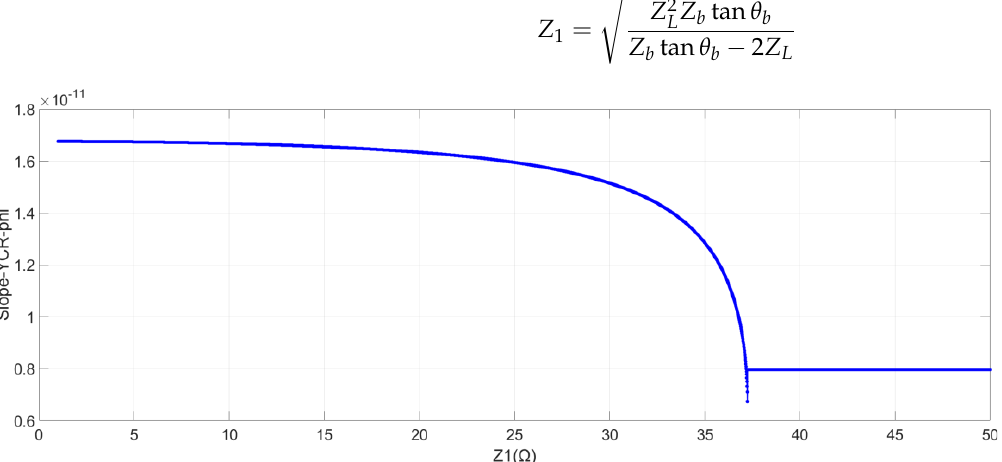
Figure 6. T he relationship between the phase of admittance Y CR ’ s frequency-dependent slope and Figure 6. The relationship between the phase of admittance Y CR ’s frequency-dependent slope and Z 1 . Z 1 . The 8.5 GHz center frequency is established. For the proposed bias circuit, Z b was set to 200 Ω and θ b to 30 ◦ , after which the initial values of Z 1 and θ 1 were set to 36.6 Ω and 53.1 ◦ , respectively, according to (11) and (12). For the traditional bias circuit, Z b was set to 200 Ω and θ b to 90 ◦ , and Z 1 and θ 1 were set to 50 Ω and 53.1 ◦ . The traditional and proposed bias circuits are optimized and simulated by ADS (Advanced Design Software).